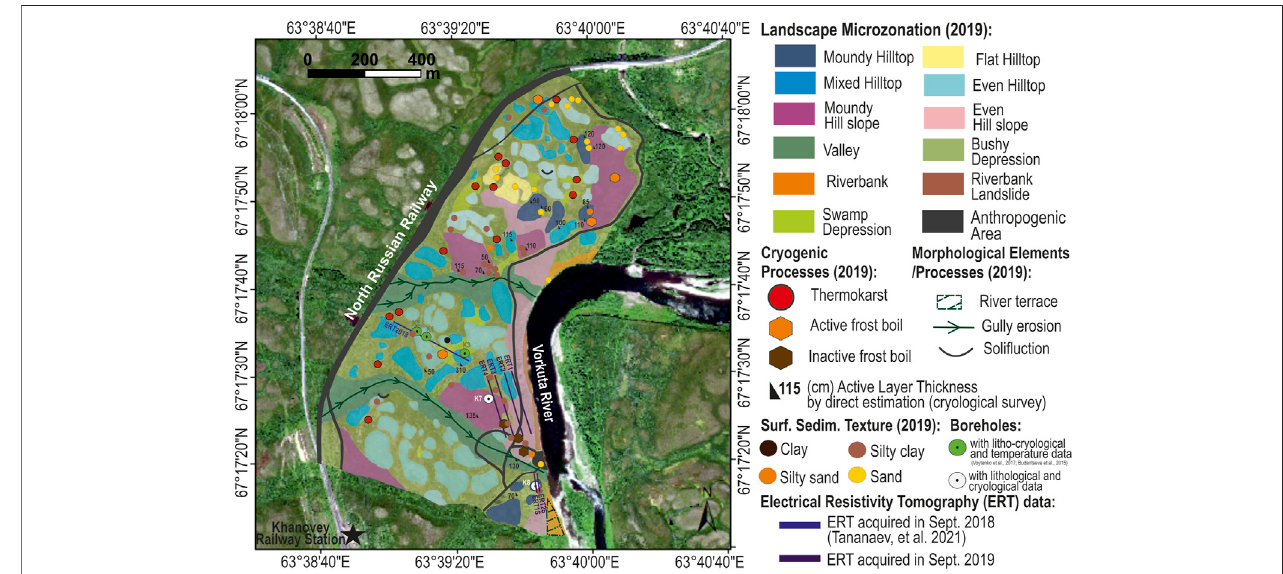
FIGURE 4 | Landscape microzonation map resulting from the morphological analysis and geocryological survey in September 2019 in the Khanovey study area. The position of boreholes and geophysical pro fi les used in this study are also shown. Silty clay deposits (brown dots) represent the major soil sediment texture type, except for the riverbank and for the northern sector, where abundant sand deposits are present (yellow dots). The active layer thickness values (direct estimations) are indicated by black triangles. Thermokarst phenomena, mainly located close to the railway embankments, is indicated by red dots; soli fl uction, inactive and active frostboils,gullyerosion,andriverterracearealsodisplayed.Thesurveyedareacanbesubdividedinto12differentlandscapesasindicatedinthelegendandin Table1 . Map compiled using ArcGis ® (Esri) software. Datum: WGS84; projection: UTM 41N. Satellite base image (Gis layer “ World Imagery ” ) retrieved in 2019 from the ArcGis online database